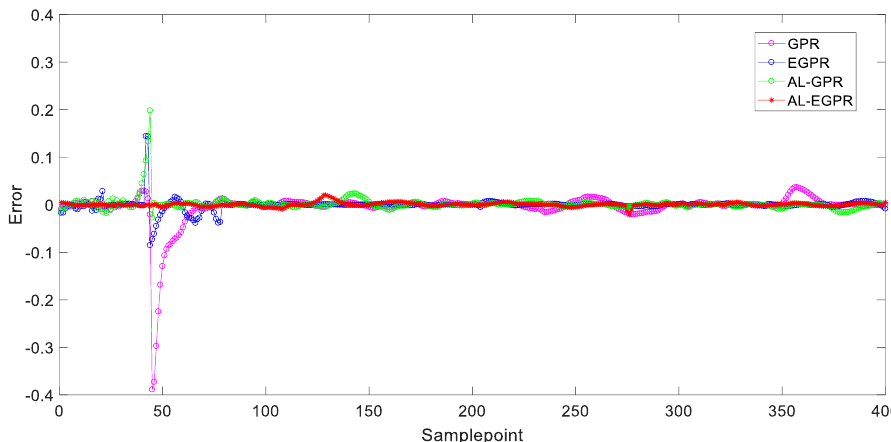
Figure 13. Prediction error of test samples for four different soft sensors after the 3 rd iteration.